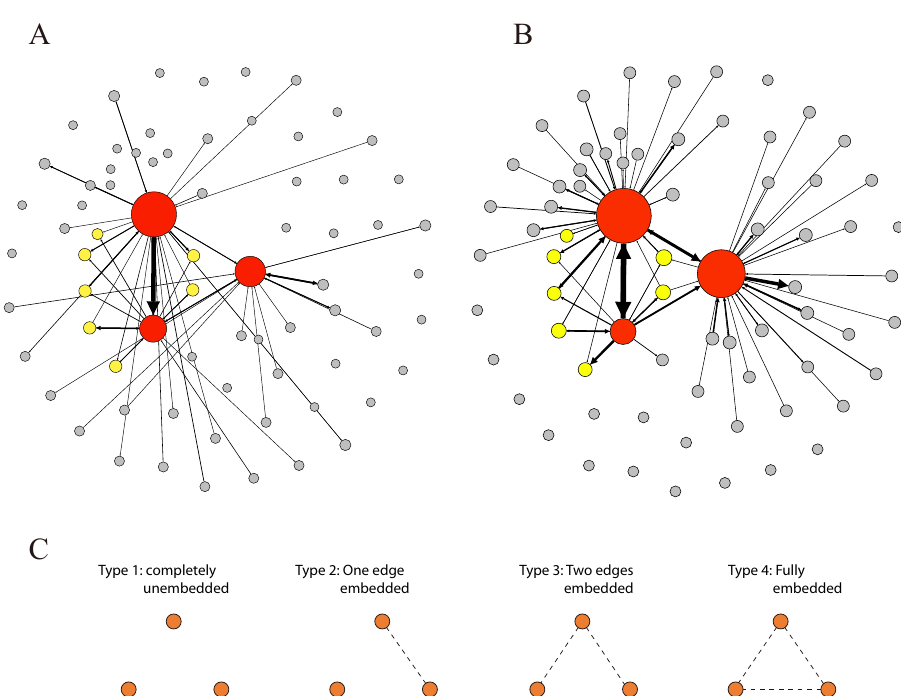
Fig. 1 Embeddedness structure of triadic family networks. A , B The call network of a randomly drawn family from our dataset during the week prior to the earthquake ( A ) and the fi rst week after the earthquake ( B ) are illustrated. Node size corresponds to degree centrality; edge width to communications frequency, i.e., tie strength. Red nodes are family plan members; yellow nodes are embedded with family members; gray nodes are unembedded alters. C Illustrates our concept of embeddedness structure where an edge (dotted line) represents embeddedness relations (i.e., edge if two nodes share at least one friend; no edge if pair have no shared friends) rather than direct ties or communications frequency (as is the case for standard network graphs, such as A and B ). There are four basic types of embeddedness structures for three-person families; a family can be fully embedded (type 4; 60.4%) or completely unembedded (type 1; 7.4%) even when the members have direct communications with each